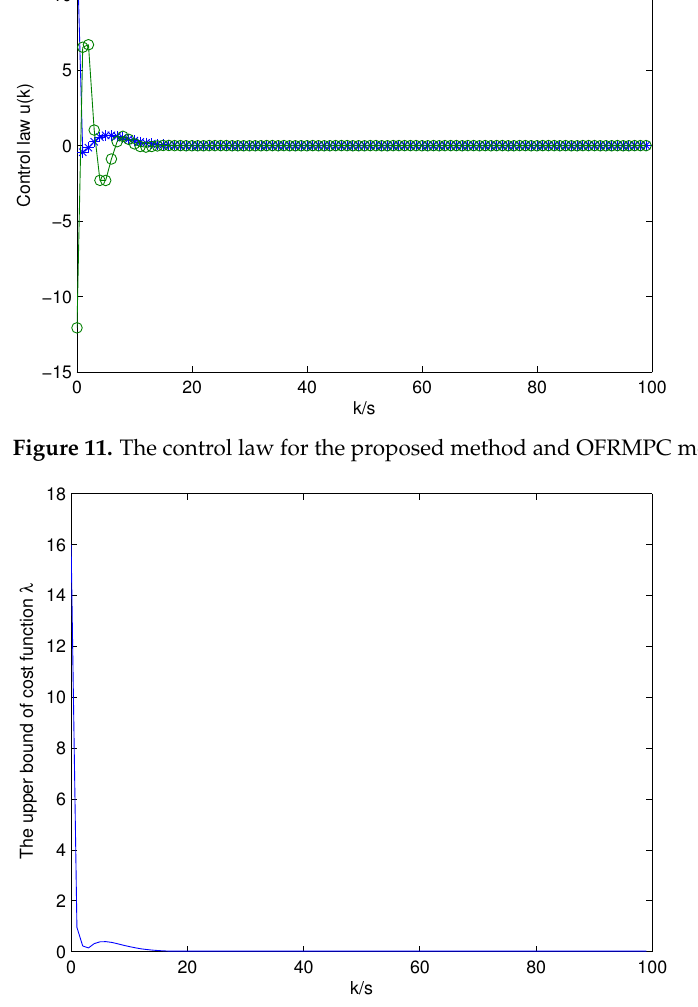
Figure 12. The curve for the upper bound of the cost